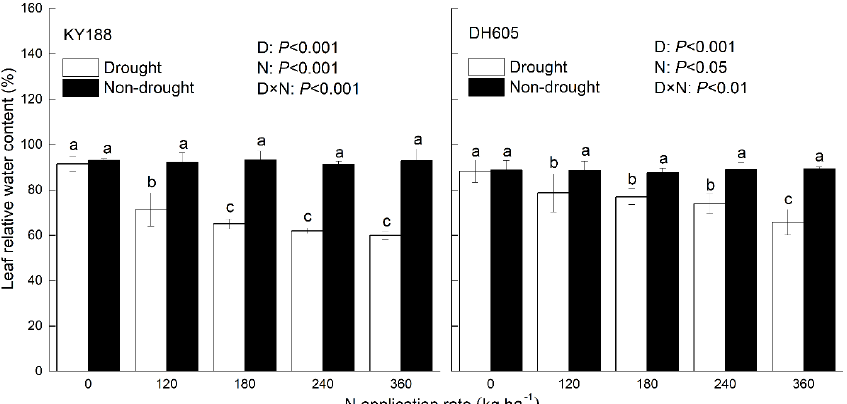
Figure 4. Relative water content of maize leaves grown subjected to drought and nondrought stress under di ff erent N levels. Significant di ff erences between two water conditions at the same N level are indicated by ns (no significance), * ( p < 0.05), and ** ( p < 0.01). Di ff erent letters in the same column denote significant di ff erences between di ff erent treatments for the same cultivar ( p < 0.05). Each bar represents the mean ± SD (n =